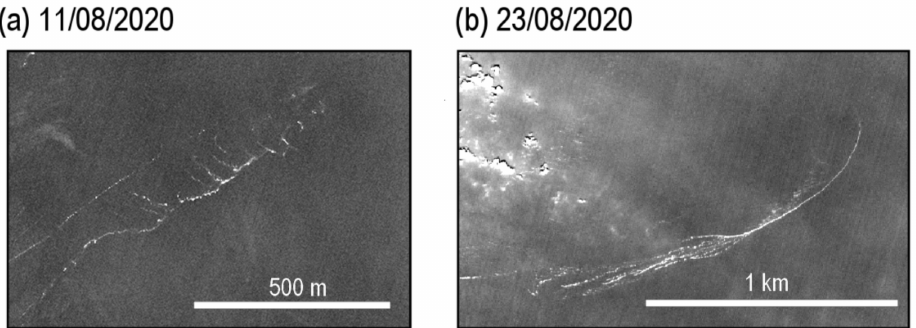
Figure 14. Drifting patches on the windy dates of Table 1 (in band 8). ( a ) NW wind. ( b ) NE